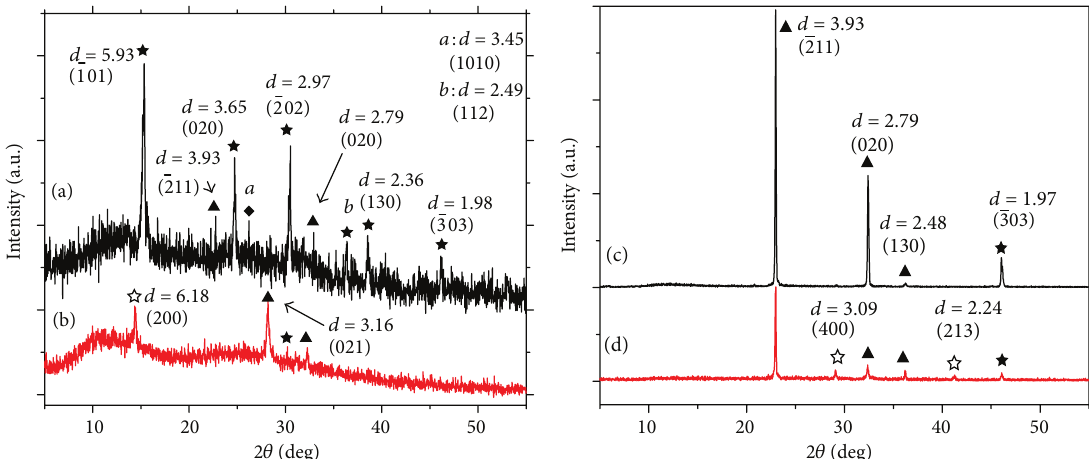
Figure 3: XRD patterns of urinary crystals of two patients with CaOx calculi before ((a), (c)) and after ((b), (d)) K 3 cit intake. 󳀅 : COM; f : COD; 󳵳 : uric acid; X : 𝛽 -Ca 3 (PO 4 ) 2